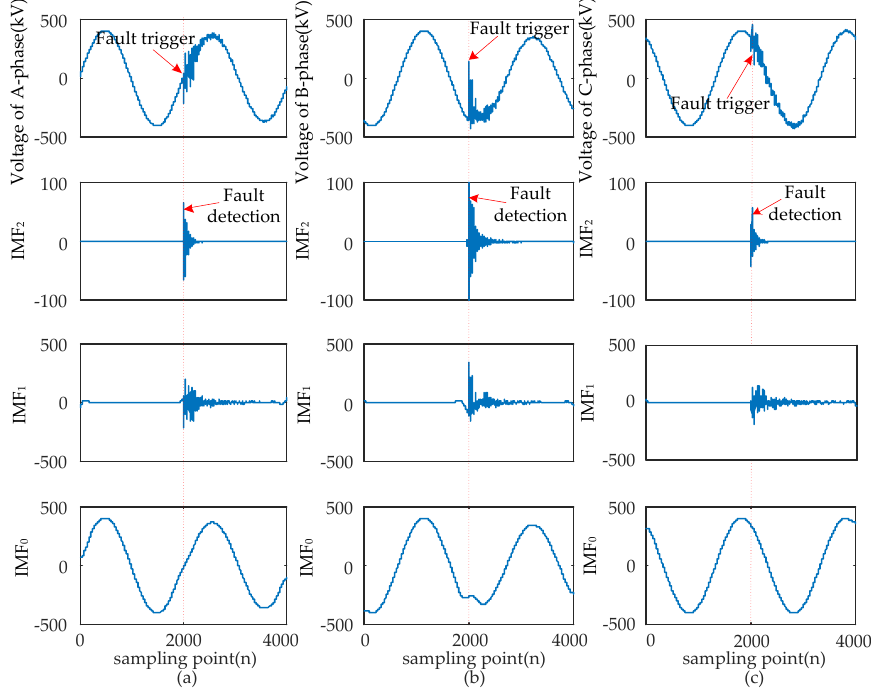
Figure 6. ABG fault signal’s modes extracted by the EWT are shown as follows: ( a ) A-phase voltage and its IMFs; ( b ) B-phase voltage and its IMFs; ( c ) C-phase voltage and its IMFs.